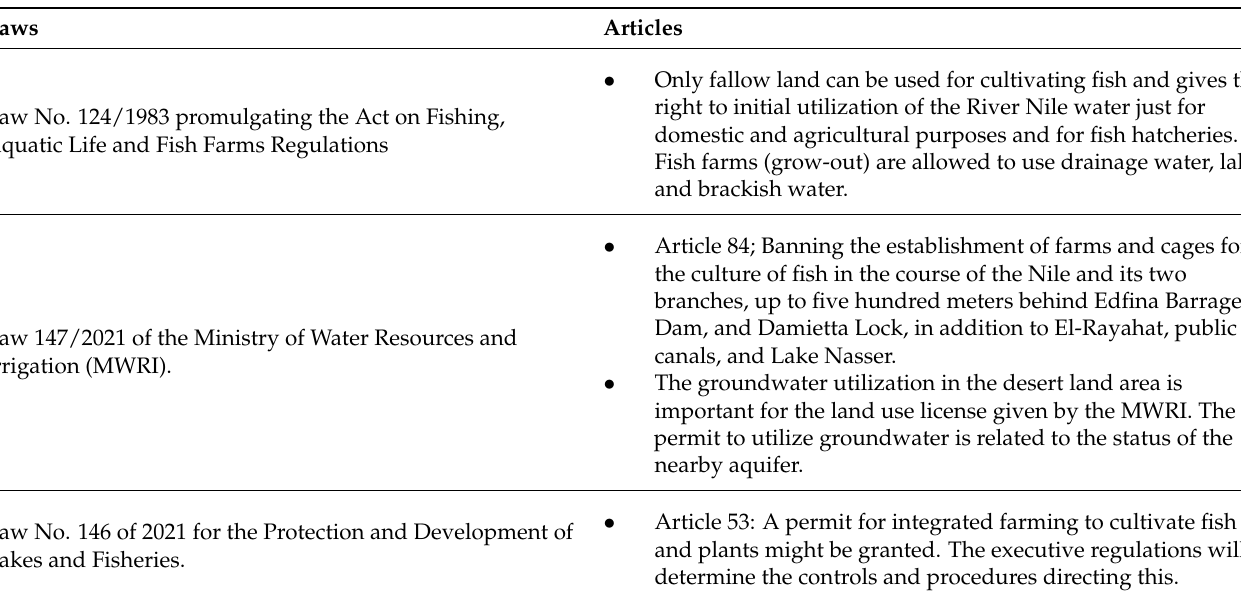
Table 4. Egypt’s legal framework for